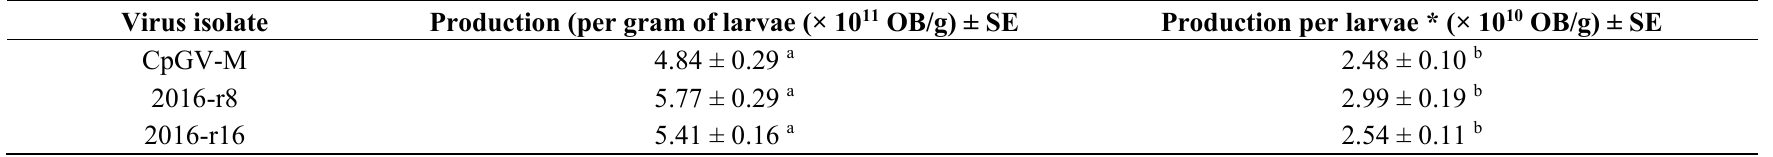
Table 1. Production per larvae and per gram of larvae of three virus isolates on susceptible insects.